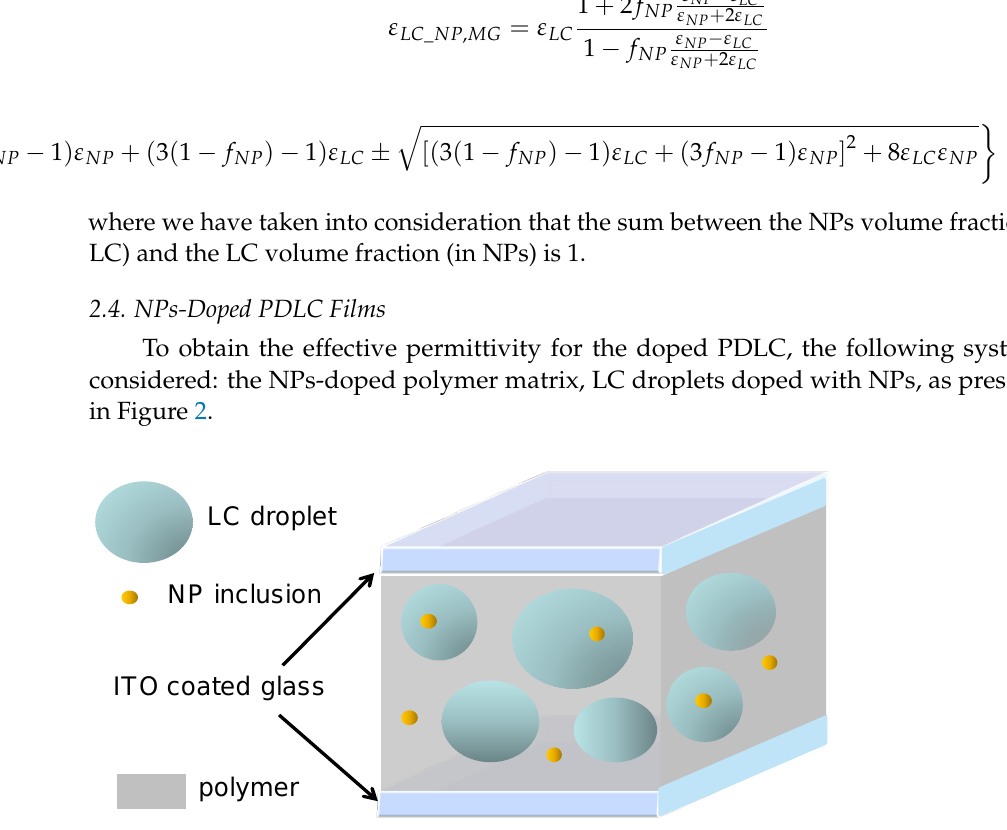
Figure 2. Schematic presentation of a nanoparticles (NPs) polymer-dispersed liquid crystal (PDLC)-doped film between two indium tin oxide (ITO) glass coated plates: LC droplets are spherical.